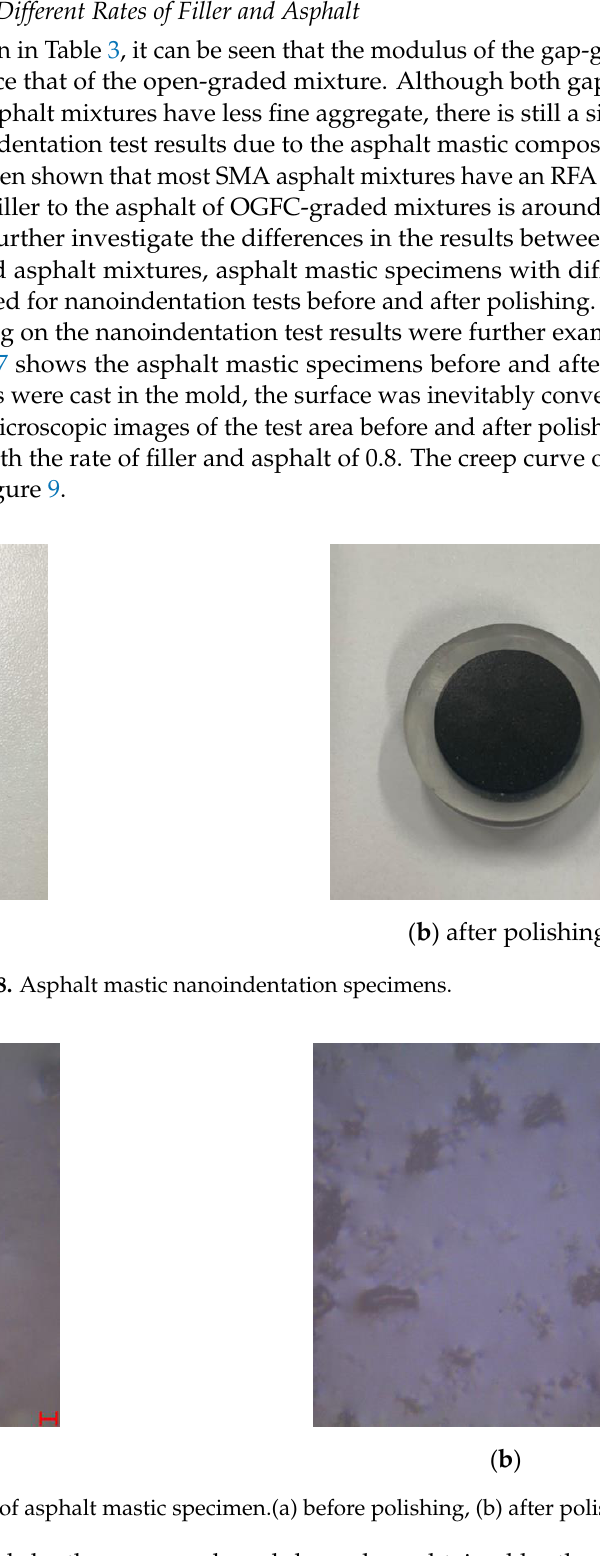
Table 3. Nanoindentation modulus of different gradation asphalt mixtures.